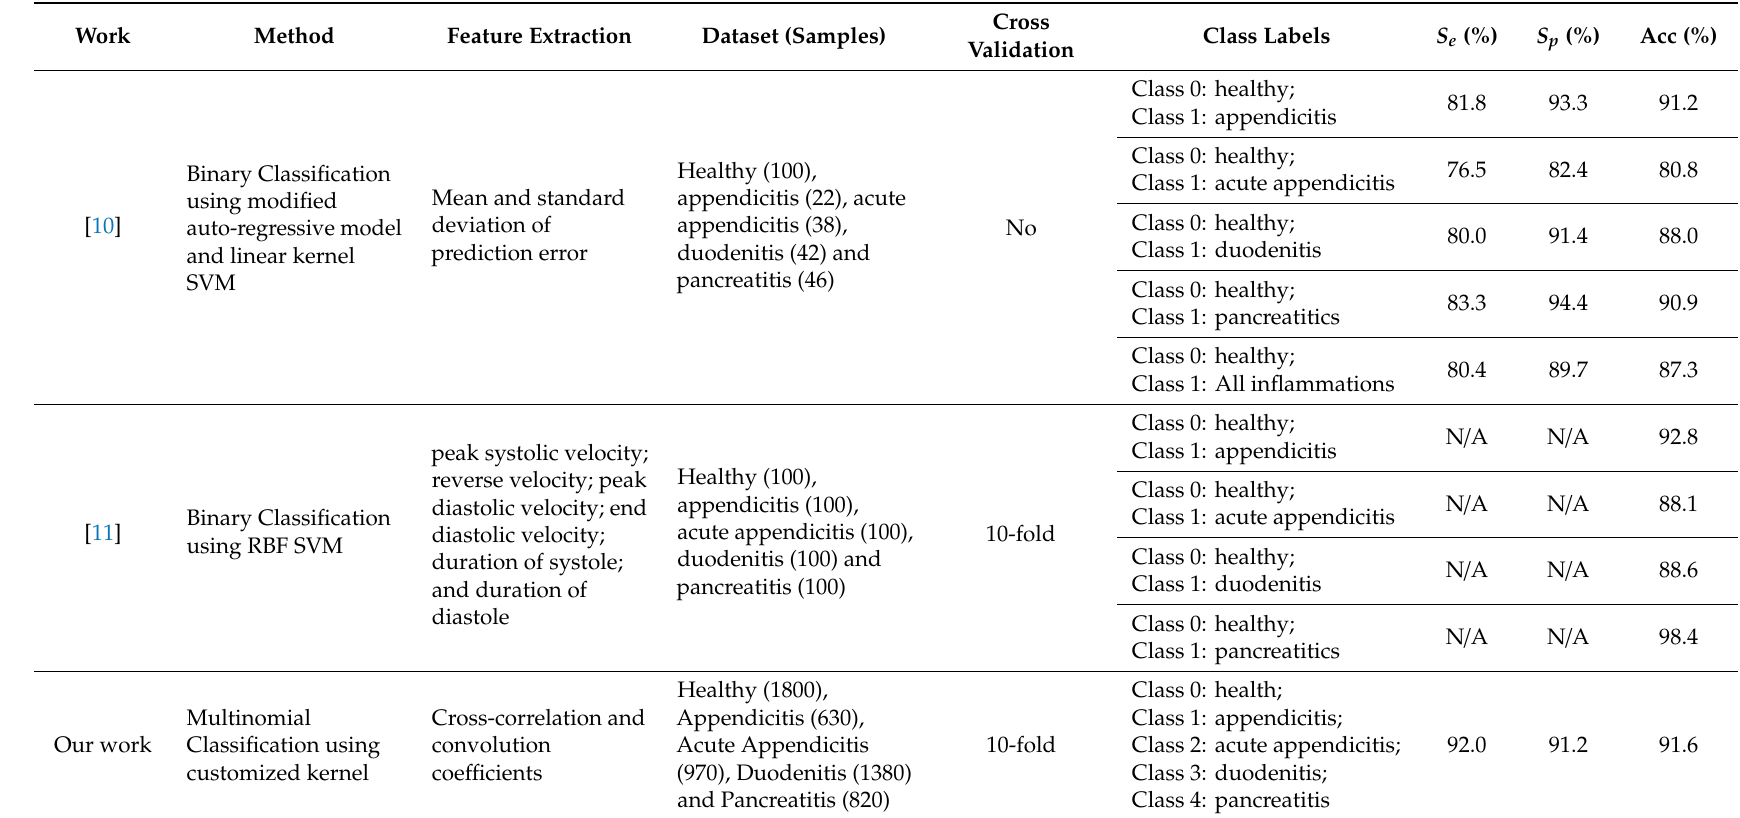
Table 4. Raw comparison between proposed and related work